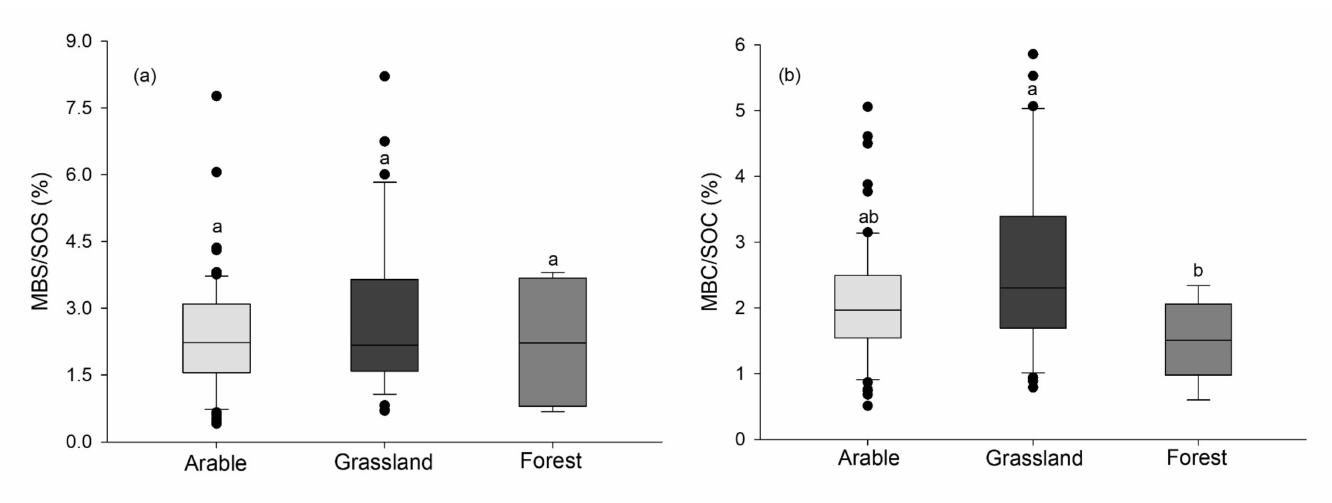
Figure 2. ( a ) MBS/SOS ratios in arable ( n = 72), grassland ( n = 39), and forest soils ( n = 4) as well as ( b ) MBC/SOC ratios in arable ( n = 65), grassland ( n = 36), and forest soils ( n = 5); different letters on top of outliers or whisker caps indicate a significant difference ( p < 0.05, Holm–Sidak